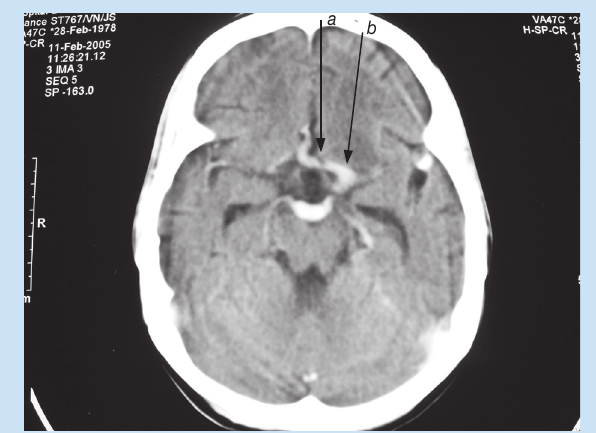
Fig. 1. CT scan of the brain with IV contrast: An area of narrowing (a) at the origin of prominent anterior cerebral artery, and (b) left middle cerebral artery.